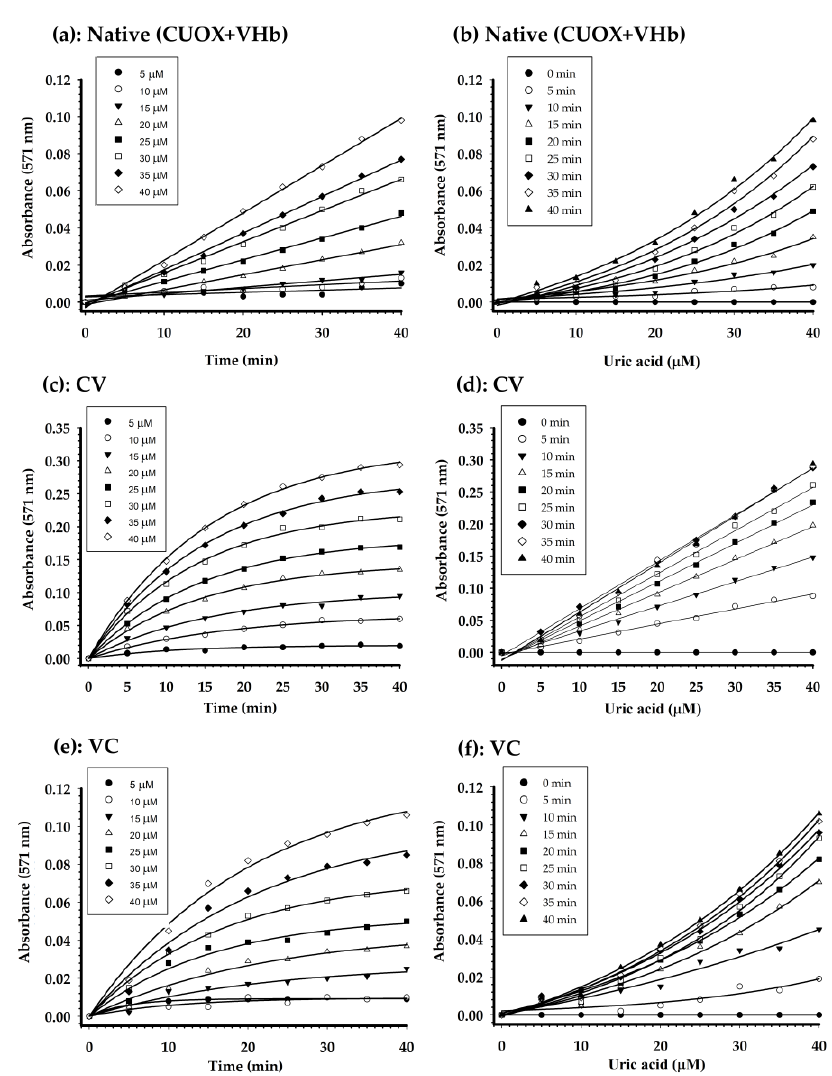
Figure 8. Quantification of uric acid using native enzyme (CUOX + VHb) ( a , b ), CUOX-VHb fusion protein ( c , d ) and VHb-CUOX fusion proteins ( e , f ). The graphs representing absorbance over time of reactions with di ff erent concentrations of uric acid ( a , c , e ) were transformed to the graphs showing calibration curves at di ff erent time points ( b , d , f